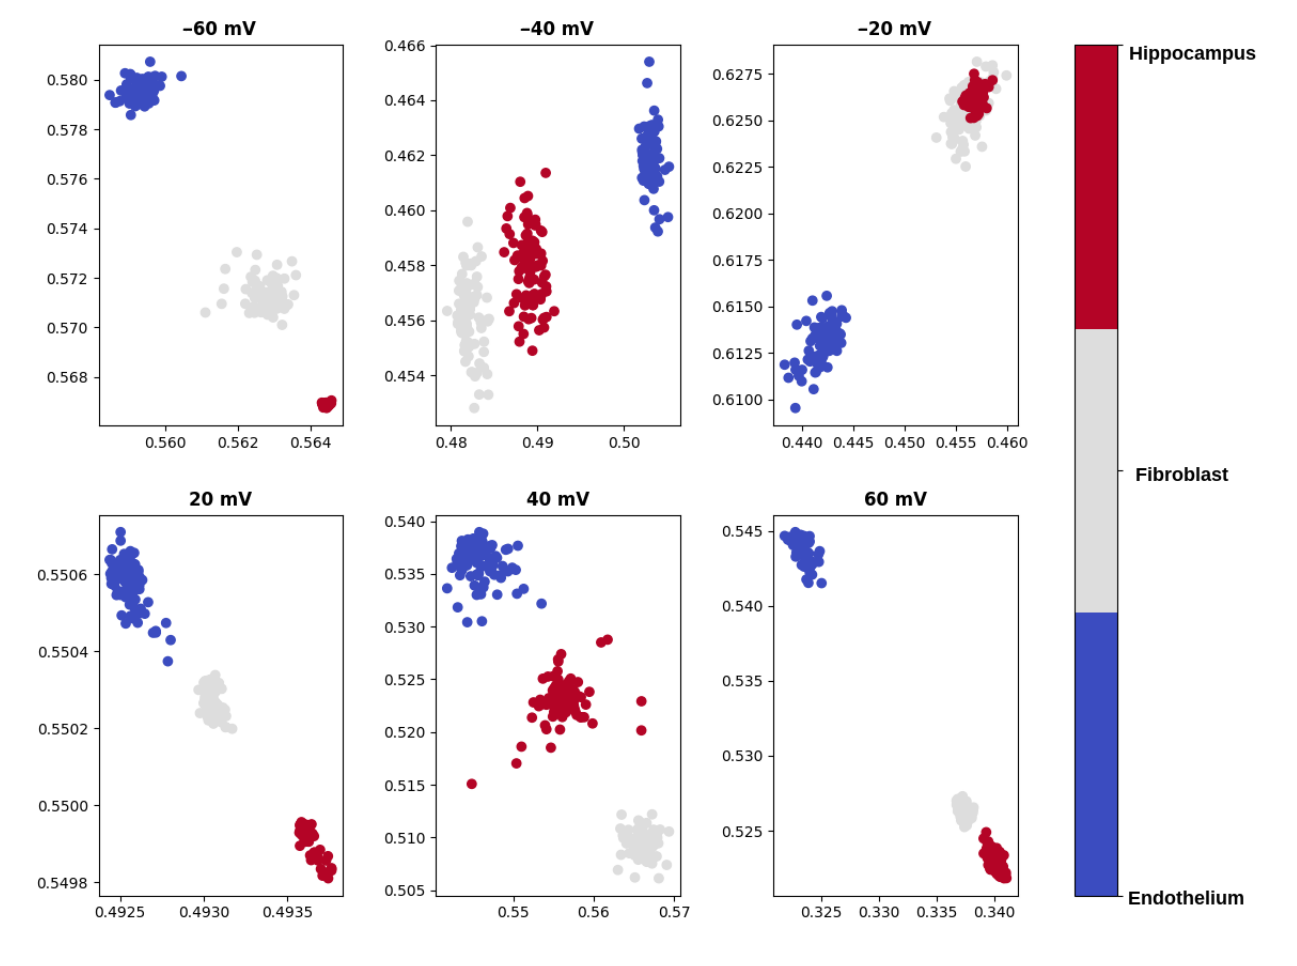
Figure 2. An exemplary visualization of the recordings reduced to a 2-dimensional space with the autoencoder correspond- ing to different pipette potentials and different cell types. Each dot represents a 1000-data-points-long subseries from the original recording. Some of the dots overlap each